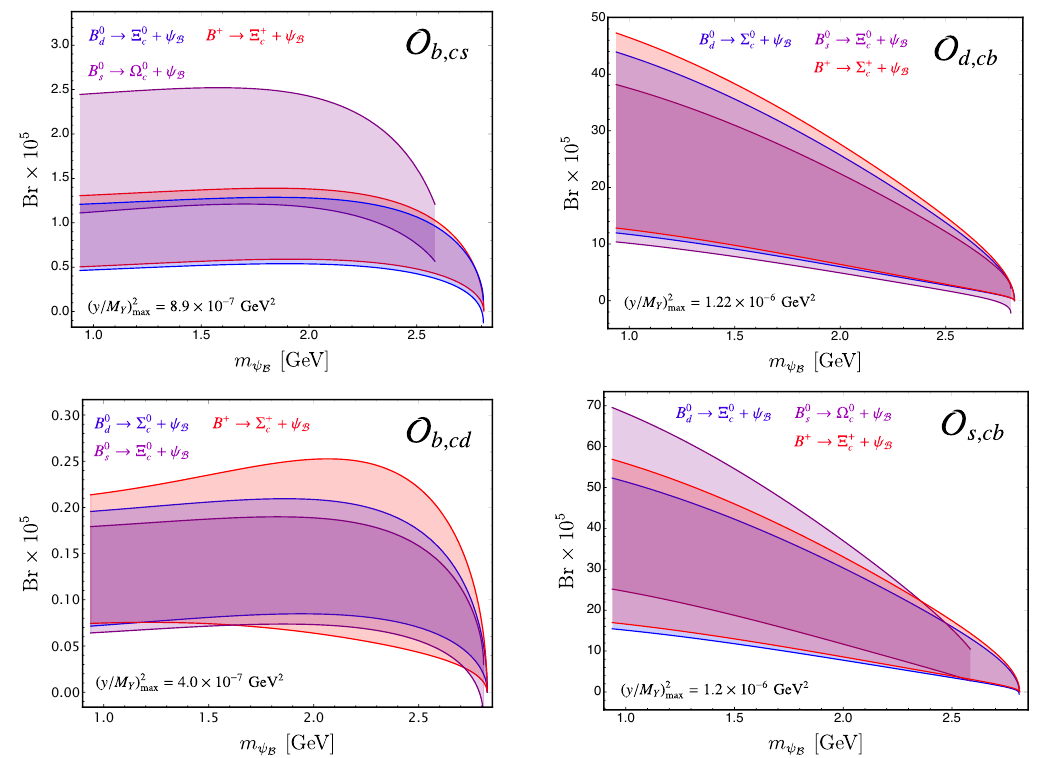
Figure 3 . Branching fractions for decays from the charmed operators ψ B b c d and ψ B b c s ; the bottom two rows of table 1. See appendix A.2 for a treatment of the DA for heavy quarks.